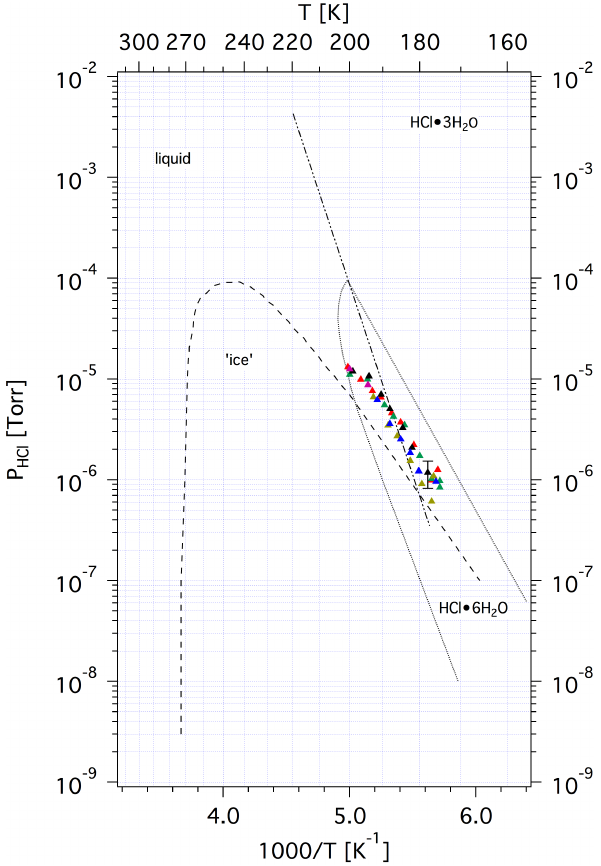
Figure 4: Binary phase diagram of the HCl/H 2 O system reconstructed from Molina and coworkers (Abbatt, 1992; Molina, 1994; Wooldridge, 1995). The full triangles represent calculated values of P eq (HCl) for amHCl using the kinetic data of the present work. Different colours represent different experiment series.